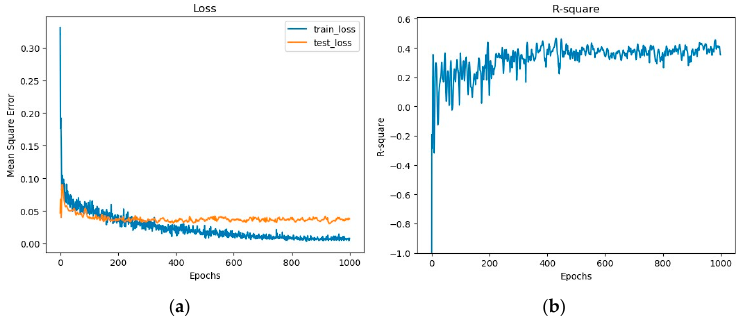
Figure 6. ( a ) Loss plot and ( b ) coefficient of determination (R-square) values for the back-propagation algorithm.